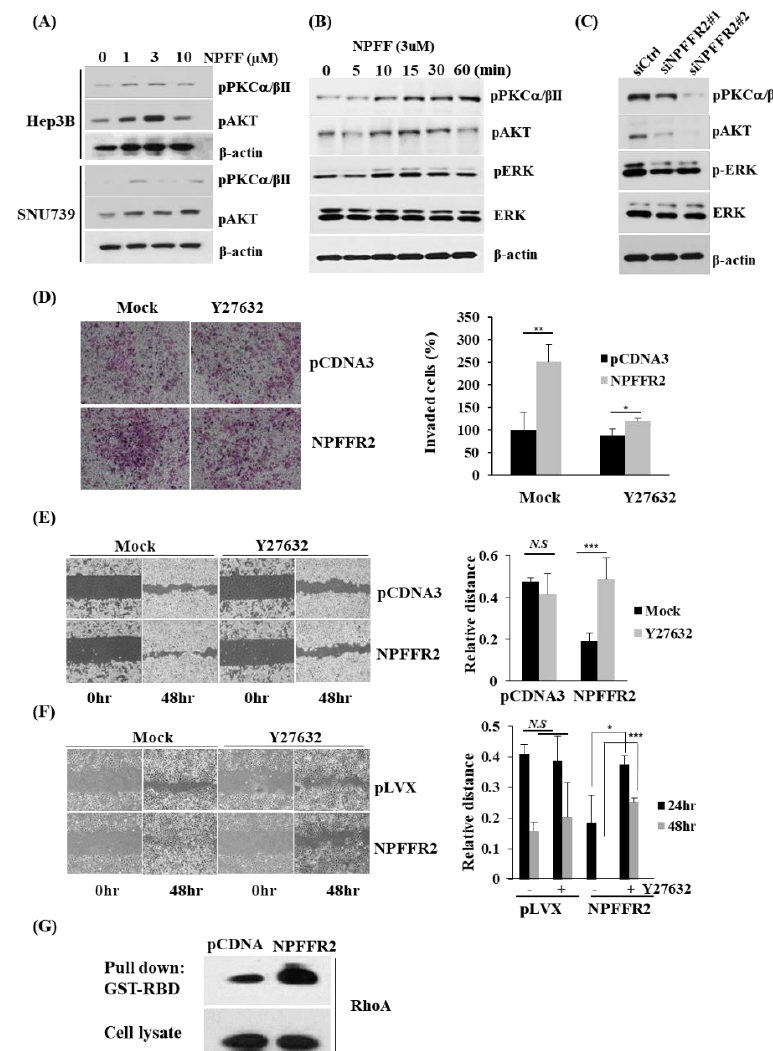
Figure 5. Invasiveness of NPFFR2 depends on RhoA activity. ( A , B ) NPFF activates GPCRs, thereby activating AKT, PKC, and ERK signaling. SNU739 ( A , B ) and Hep3B ( A ) cells were starved for 12 h, treated with peptides by concentration for 15 min ( A ) or by time at a concentration of 3 μM ( B ), and harvested for Western blotting. ( C ) NPFFR2 was depleted in SNU739 cells using siRNA, and cells were harvested for Western blotting after 48 h. ( D ) The effect of Rho activity on NPFFR2–induced cell invasion was analyzed4 h after transfection, Huh7 cells were seeded into a transwell, and the upper and lower wells were simultaneously treated with Y27632 (5 µM). ( E ) The effect of Rho activ- ity on NPFFR – induced cell migration was analyzed. Transfected Huh7 cells ( E ) or SNU475 stable cell lines ( F ) were seeded in the migration chamber and confluent cells were starved for 6 h. Media was changed to complete media containing Y27632 after a generation of cell – free gap. ( D – F ) Exper- iments were performed in triplicate and the data are presented as mean ± SD. ( G ) NPFFR2 overex- pression increases RhoA activity. RhoA activity assay was performed using NPFFR2 – transfected Huh7 cells. Cell lysates were incubated with Glutathione Sepharose bead – bound GST – fusion pro- tein of the Rho – binding domain of Rhotekin (GST – RBD) to capture GTP – bound RhoA. RhoA – GTP protein expression was detected using RhoA antibodies. * indicates p ≤ 0.05, ** indicates p < 0.01, *** indicates p < 0.001, N.S. indicates non – significant ( p > 0.05) . 3.6. Regulation of RhoA by NPFFR2 Affects the Formation of F – Actin and the Activity of YAP RhoA is known to activate cell migration by re – organizing the actin cytoskeleton [29]; therefore, we analyzed the distribution of F – actin under NPFFR2 overexpression by stain- ing with Phalloidin. The fluorescence intensity of phalloidin increased by NPFFR2